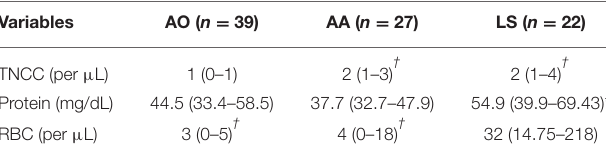
TABLE 2 | Comparison of fluid analysis parameters across samples with normal cytology.